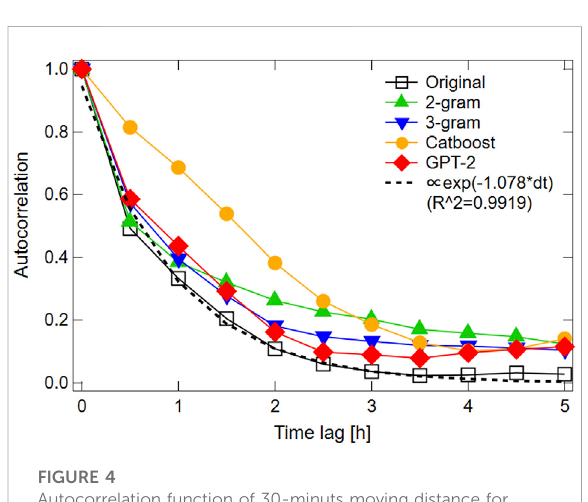
FIGURE 3 Distribution ofhourlymoving distanceinastraightline for ( □ )original trajectory and trajectories generated by( ▲ )2-g, ( ▼ )3-g, ( Catboost, and ( A ) GPT-2 models. Dashed line represents the logarithmic function. R 2 is 0.995.